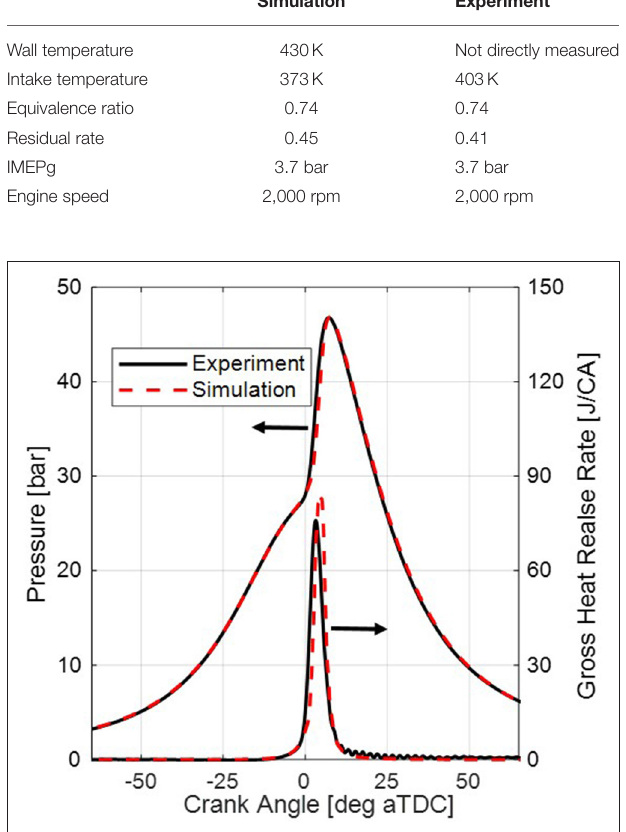
FIGURE 2 | Comparison between the CFD model and experimental results for HCCI combustion using PRF90 in the CFD simulation to represent the E10 gasoline used in the